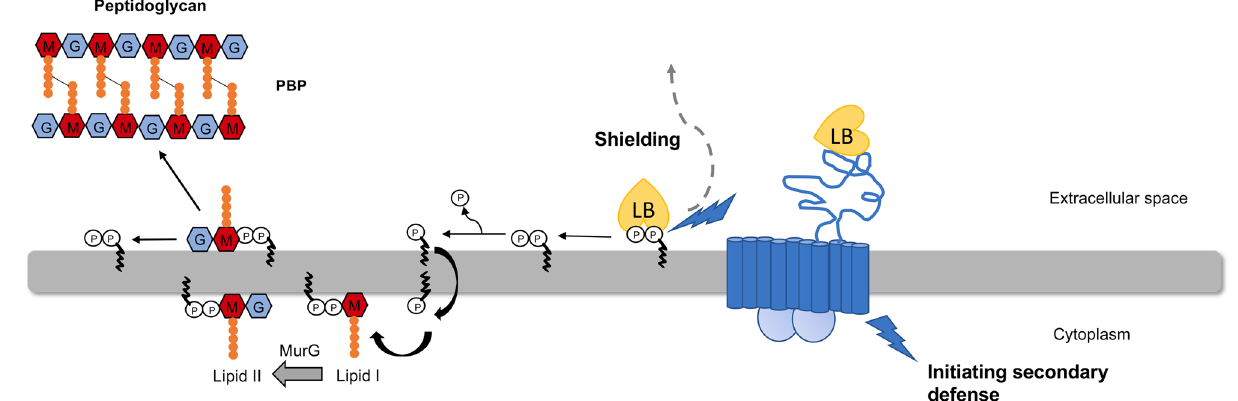
Figure 6. Schematic view of the proposed mechanism of Sa NsrFP. Phosphates are marked with a P, undecaprenyl as a black curved line, GlcNAc in blue, MurNAc in red and amino acids of the pentapeptide in orange. The transporter Sa NsrFP is shown in blue, showing its functions of sensing antibacterial attack, shielding the target most likely by releasing the target from the grip of bacitracin and initiating a secondary defense leading to possible cell wall thickening, modifying the electrostatic charge of the cell wall by integrating lipoteichoic acids and increasing d-alanylation in the cell wall. Subsequentially, the released target can enter a new cell wall synthesis cycle and be incorporated into the peptidoglycan (not shown fully here but in Fig. 1). GlcNAc N -acetylglucosamine, MurNAc N -acetylmuramic acid. The figure was created using Microsoft Powerpoint Version